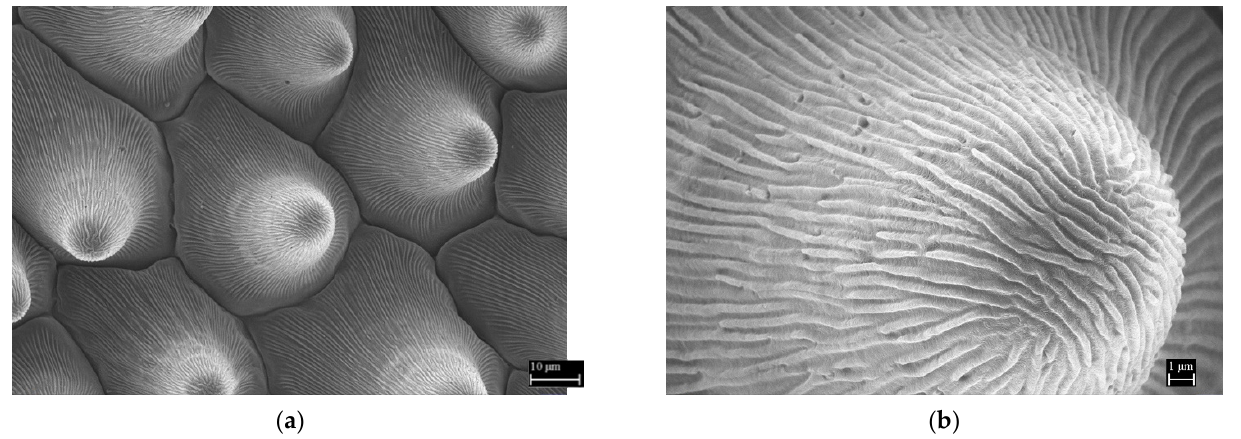
Figure 7. Polymer replica surface. ( a ) Overview microscopic image of the garden pansy polymer replica surface made of a crystallizing polymer. ( b ) Detailed image of the protrusions on the replica conical structure. Reprinted from ref. [19,20].